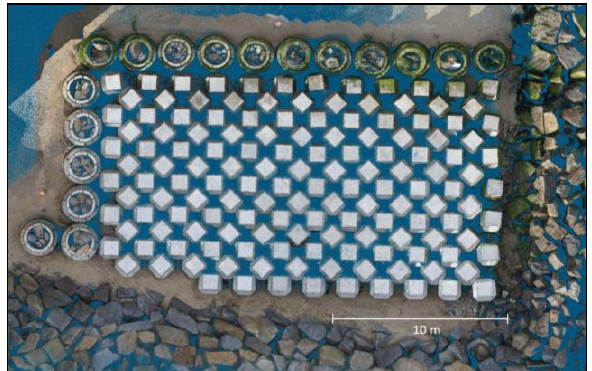
Figure 2 . Test dike in Ouistreham